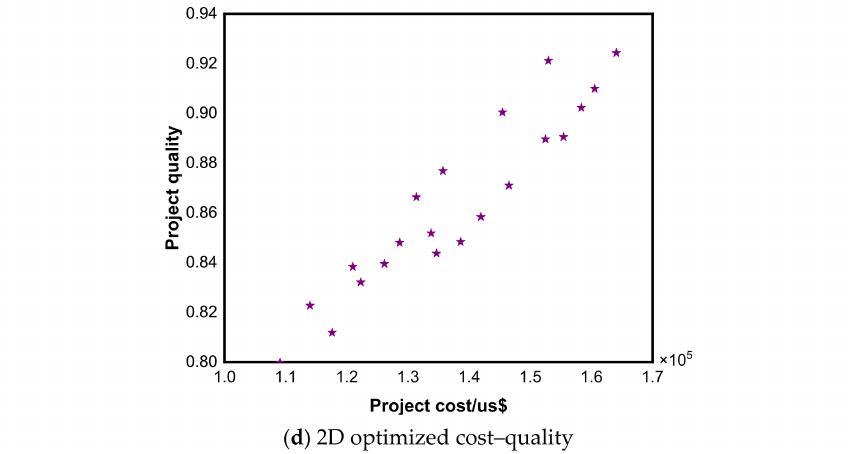
Figure 7. Model 2: 3D optimal results ( a ), and 2D period–cost, period–quality, and cost–quality relationships ( b , c , d ,